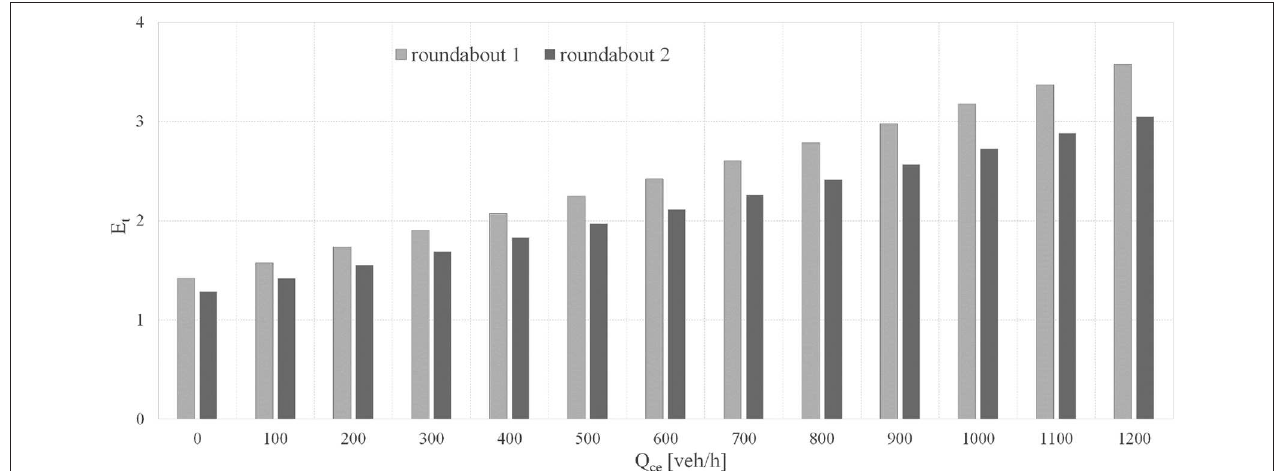
FIGURE 9 | Estimation of mean PCE S for right entry lane at roundabout 1 and roundabout 2 (Westbound approach) for percentage of heavy vehicles between 10 and 20%. Q ce , circulating flow in the outside lane [veh/h]; E t , equivalence